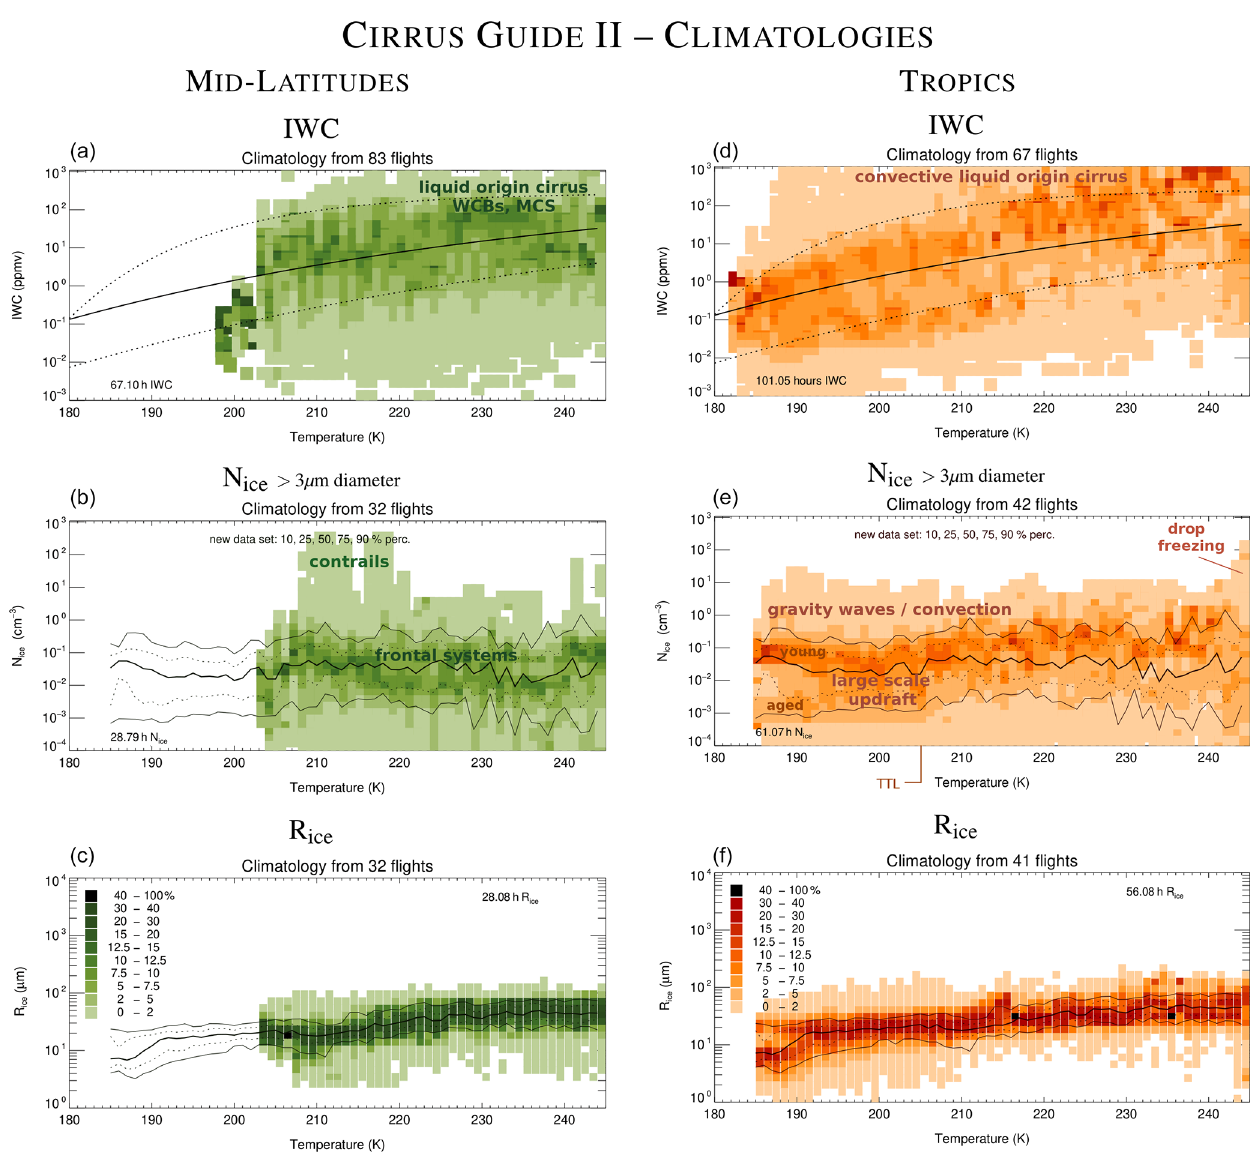
Figure 8. Same as Fig. 7a–c, but for midlatitudes and tropics (WCBs: warm conveyor belts; MCS: mesoscale convective systems; TTL: tropical tropopause layer). The field campaigns are listed in Table